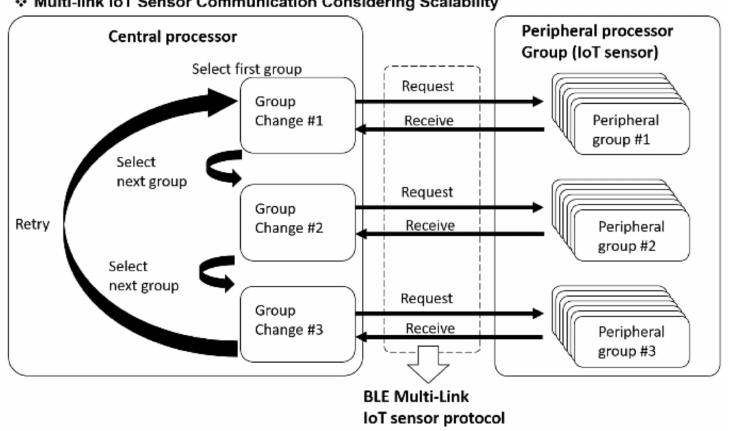
Figure 10. Concept of IoT sensor experiment using BLE multilink